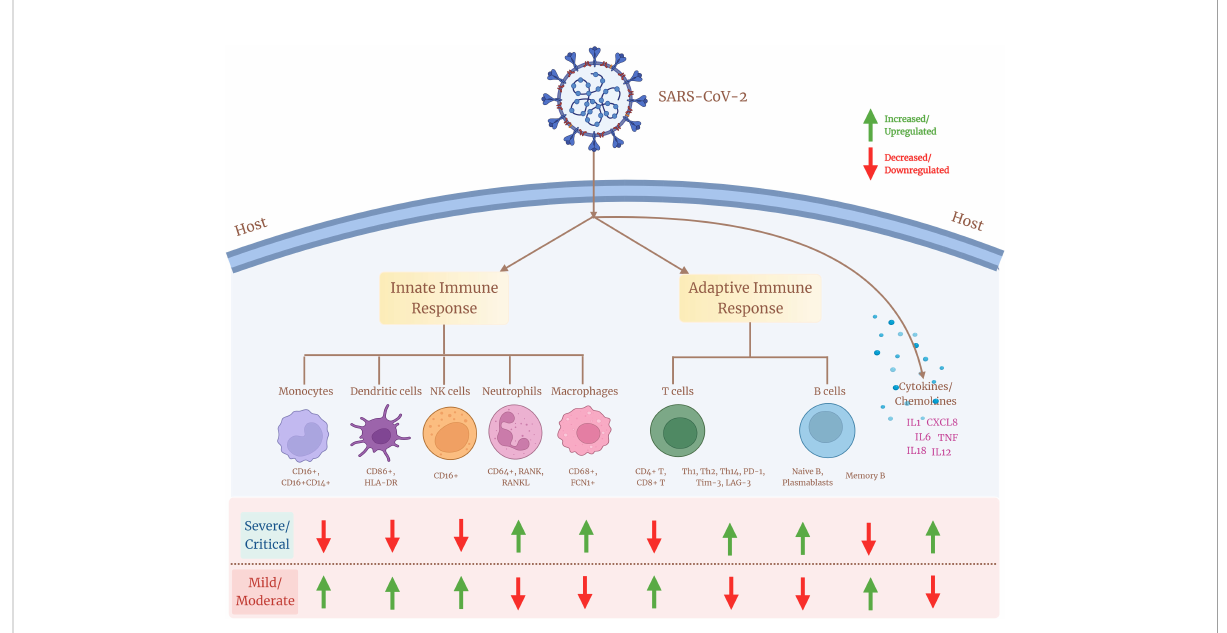
FIGURE 2 Cellular heterogeneity across the immune landscape of COVID-19 sub-disease severity phenotypes. Different cell subsets of the innate and adaptive immune system and their associated marker expression (upregulation/downregulation) showing diverse heterogeneity across patients with mild/moderate and severe/critical